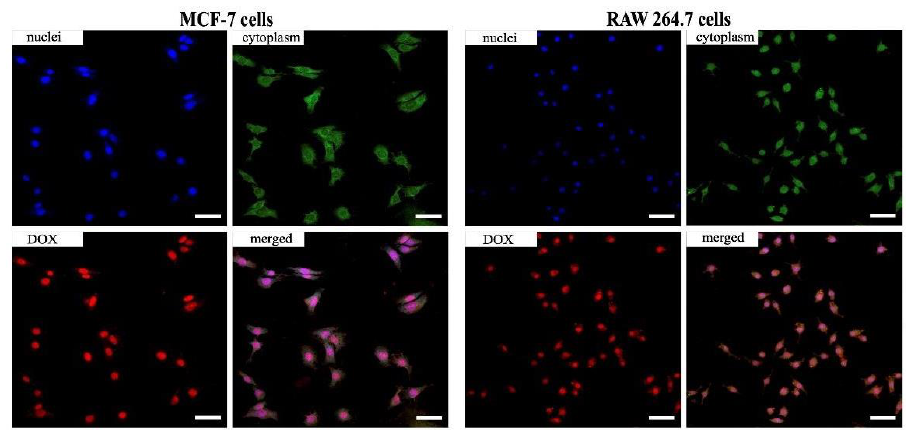
Figure 8. Intracellular distribution of the DOX-loaded MOF in MCF-7 and RAW 264.7 cells after 2 h. Cell nuclei are in blue (Hoechst 33258), cell cytoplasm in green (Calcein AM), and MOFs in red (DOX). Scale bar is 50 μm.